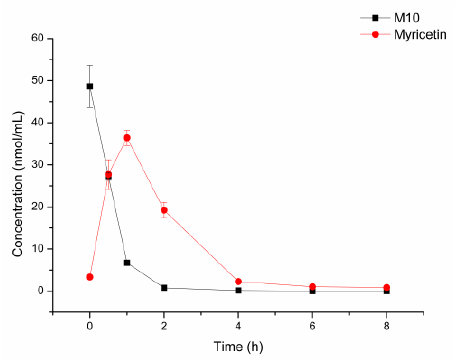
Figure 5. Incubation of M10 with fecal flora of normal mice at 37 °C (n = 3).